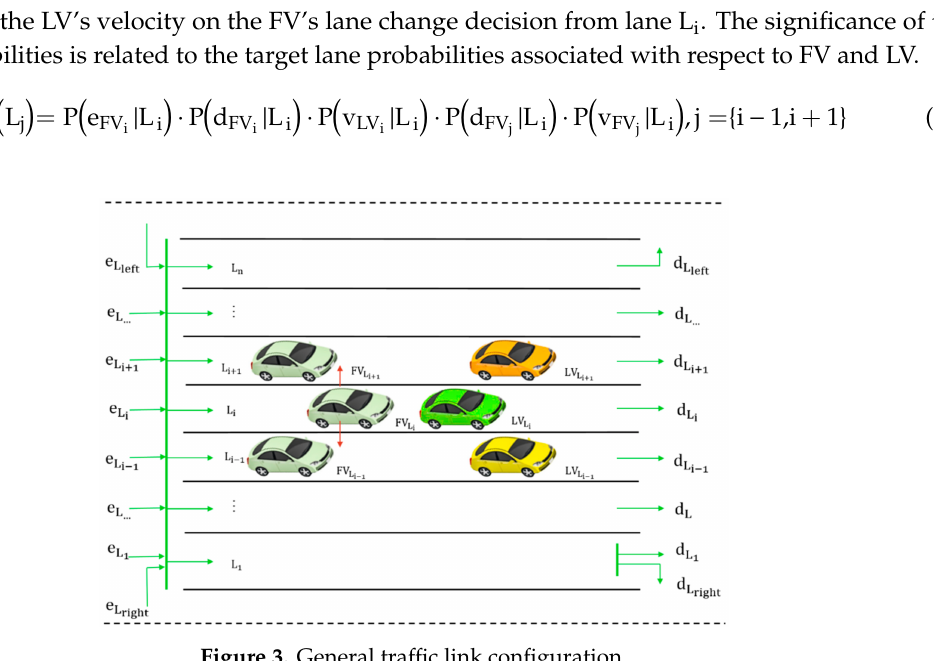
Figure 3. General tra ffi c link